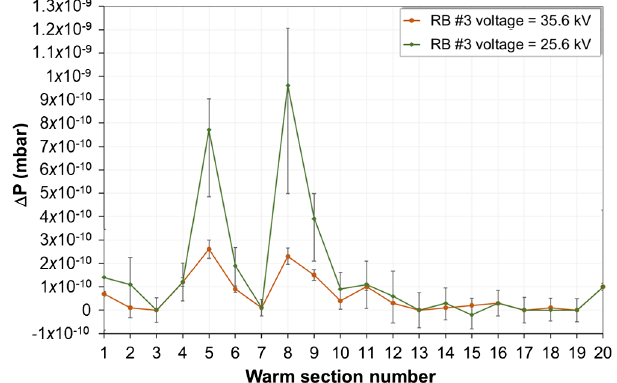
FIG. 11. Pressure variation in the SC linac warm sections as a function of the rebuncher #3 voltage, 35.6 kV (orange) and 29.6 kV (green).